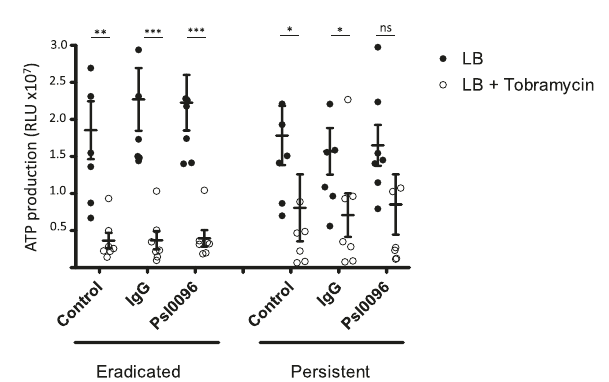
Fig. 5 SickKids P. aeruginosa isolates ( N = 7 persistent; N = 7 eradicated) were grown as bio fi lms for 24 h after which antibodies (LB control, IgG or anti-Psl 0096) and tobramycin (or LB alone) were added for the following 24 h before ATP was measured. The mean ATP activity (measured in Relative Light Units (RLU) ×10 7 ) for each isolate (done in triplicate) was calculated and the mean of all isolates was plotted with standard error of the mean (SEM). Comparisons with and without tobramycin treatment were performed for each condition using non-parametric Mann – Whitney test *** p < 0.001, ** p < 0.01, * p < 0.05, ns not signi fi